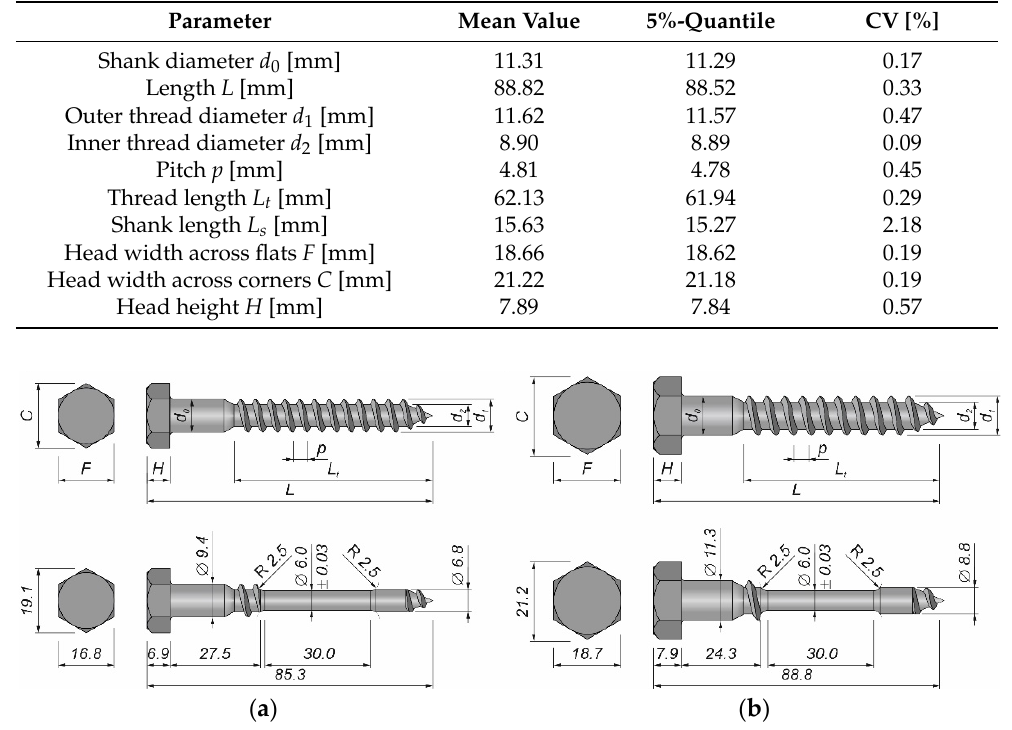
Table 4. Mean values, 5%-quantiles and coefficients of variation for the 10 mm screw used in the tests.